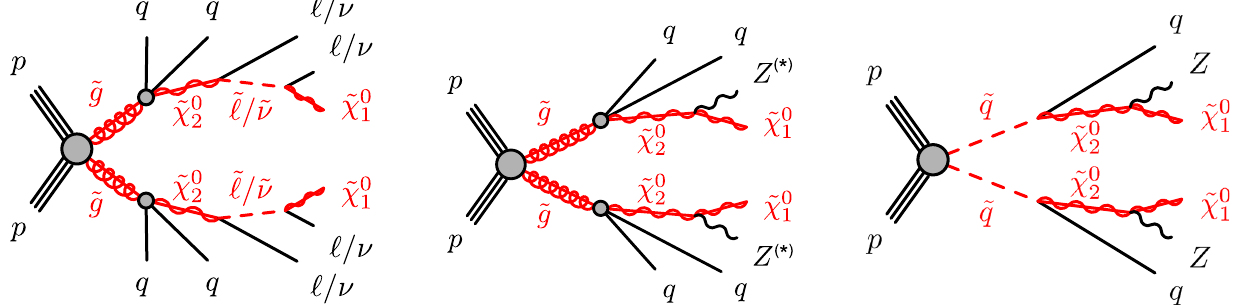
˜ χ 0 → Z ( ∗ ) ˜ χ 0 in the Z ( ∗ ) , ˜ g − ˜ χ 0 or ˜ g − ˜ χ 0 model (middle). The dia- 2 1 2 1 gram on the right illustrates the ˜ q − ˜ χ 0 on-shell model, where squarks 2 → Z ˜ χ 0 are pair-produced, followed by the decay ˜ q → q ˜ χ 0 , with ˜ χ 0 2 2 1 − m ˜ χ 0 2 1